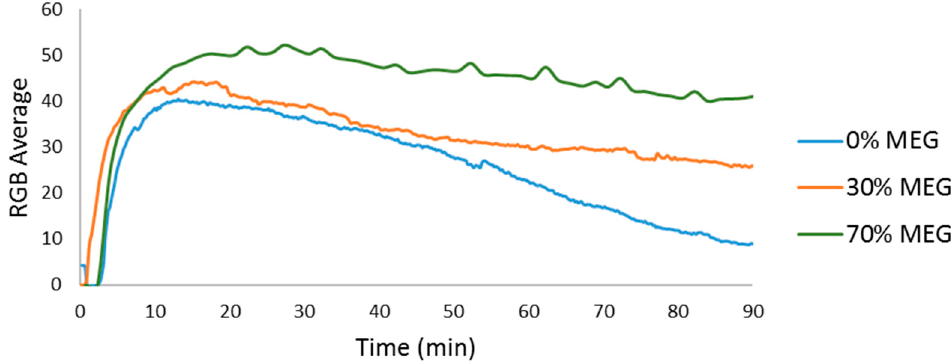
Figure 5. RGB average for calcium carbonate precipitation with three different concentrations of MEG.